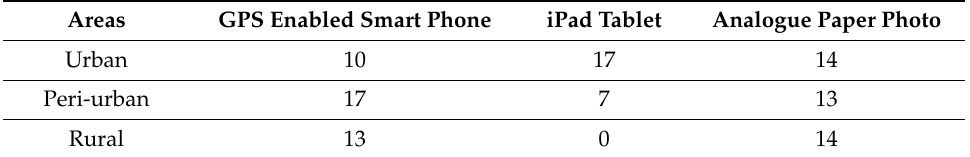
Table 4. Number of volunteer preferences for data collection methods in different communities.